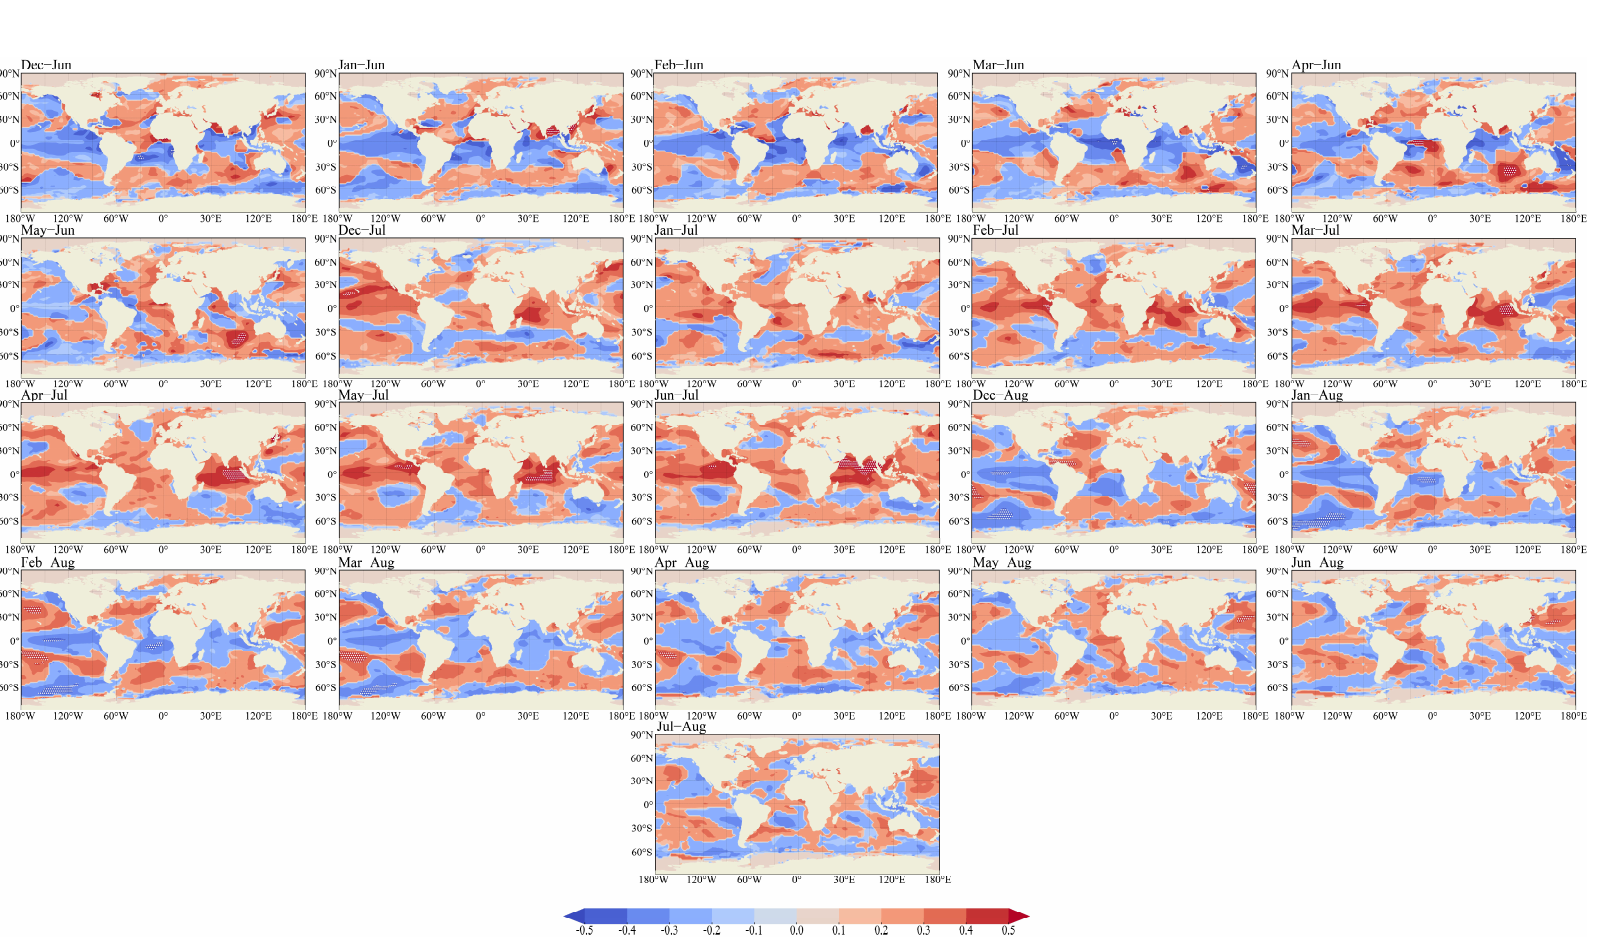
Figure 3. DC-PC relationship between global SST and summer EP in the MLYR. (The pictures from left to right represent the relationship between the EP in June and SSTs from December to May, the EP in July and SSTs from December to June, as well as the EP in August and SSTs from December to July, respectively; the areas labeled with white dots in the pictures represent the significantly correlation).